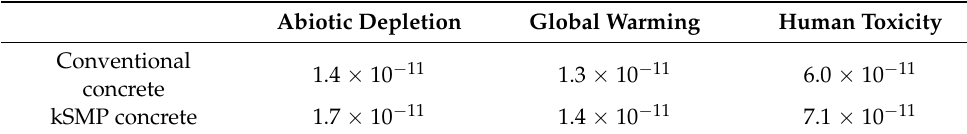
Table 2. Principal normalized impacts for Conventional concrete and kSMP Concrete.